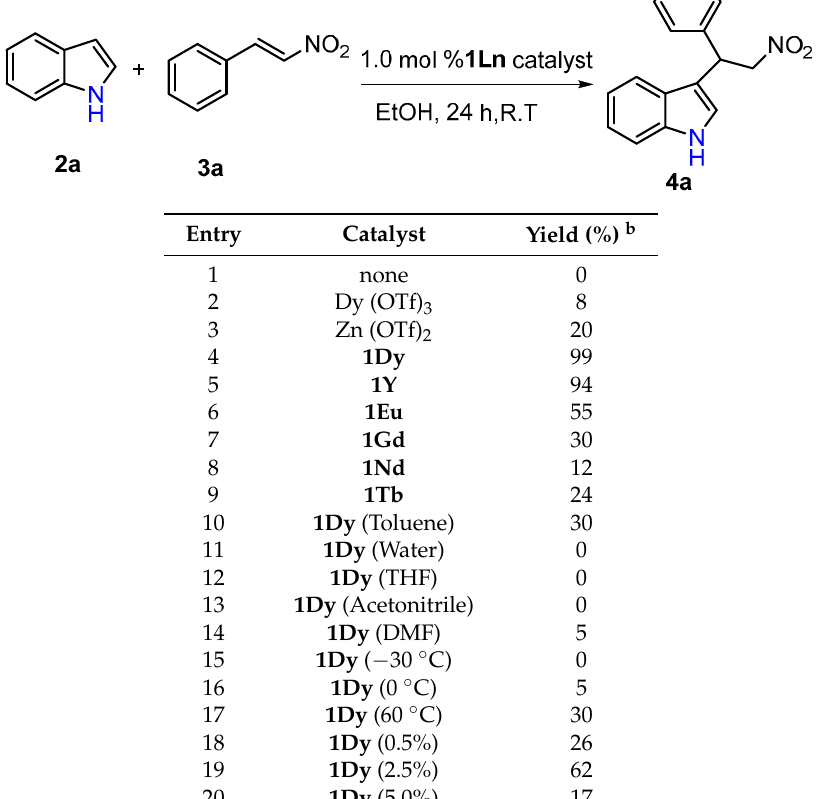
Table 1. Optimization of the Friedel–Crafts Alkylation of Indole 2a with trans ‐β‐ Nitrostyrene 3a Catalyzed by 1Ln Complexes a .